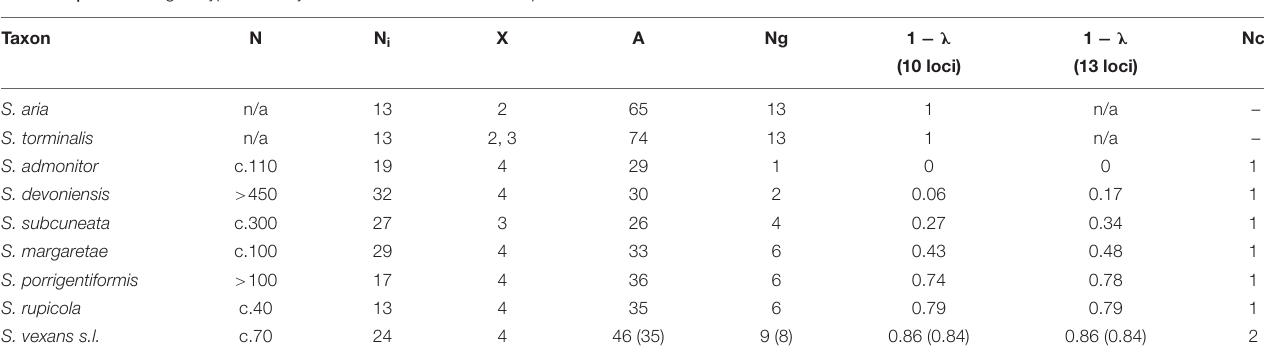
TABLE 1 | Allelic and genotypic diversity found in the studied Sorbus